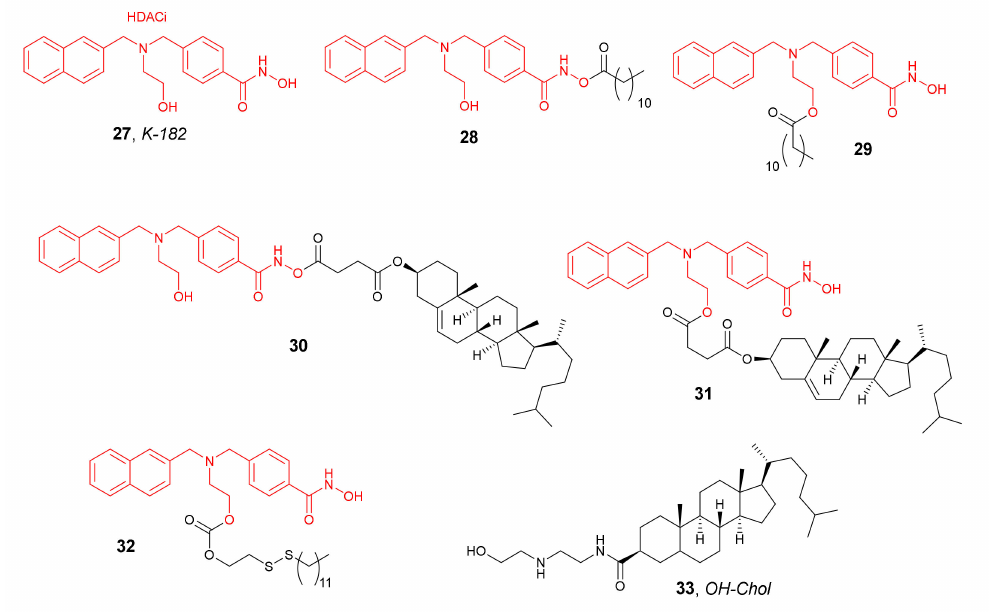
Figure 15. Chemical structures of 27 KI-182 , KI-182 prodrugs 28 – 32 , and 33 OH-Chol